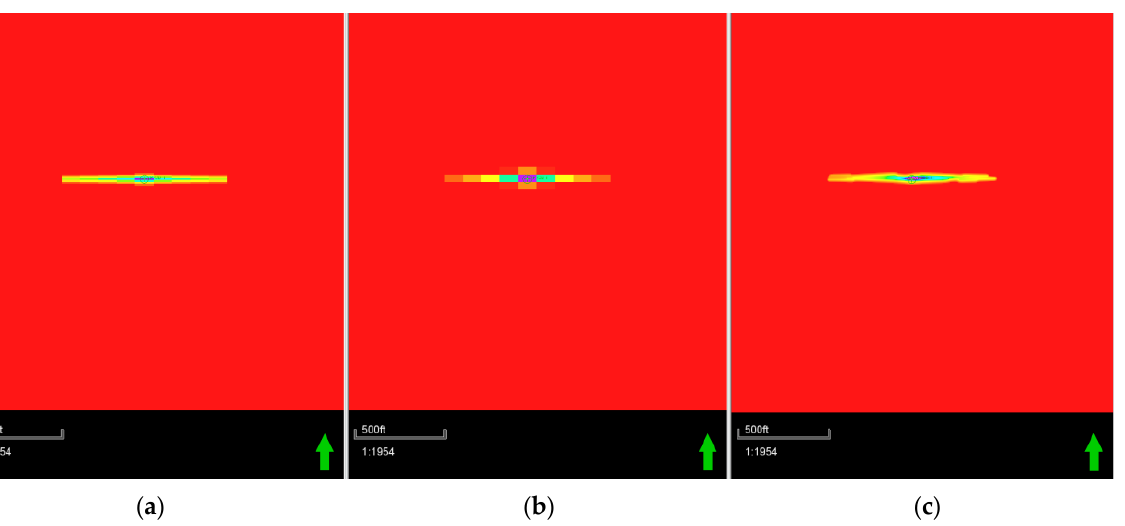
Figure 6. Pressure map in early time for ( a ) Base Case, ( b ) Coarse Case, and ( c ) Reference.